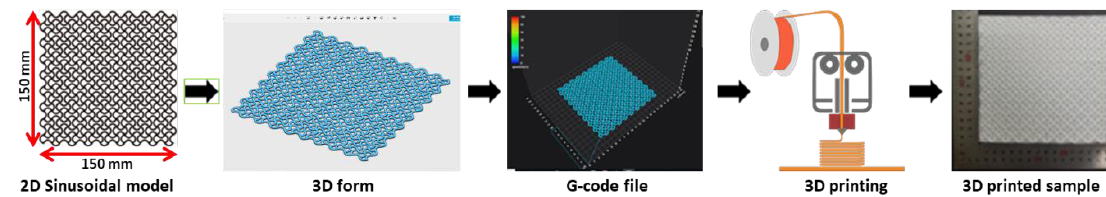
Figure 1. 3D-printing of the sinusoidal sample/nylon composite with various